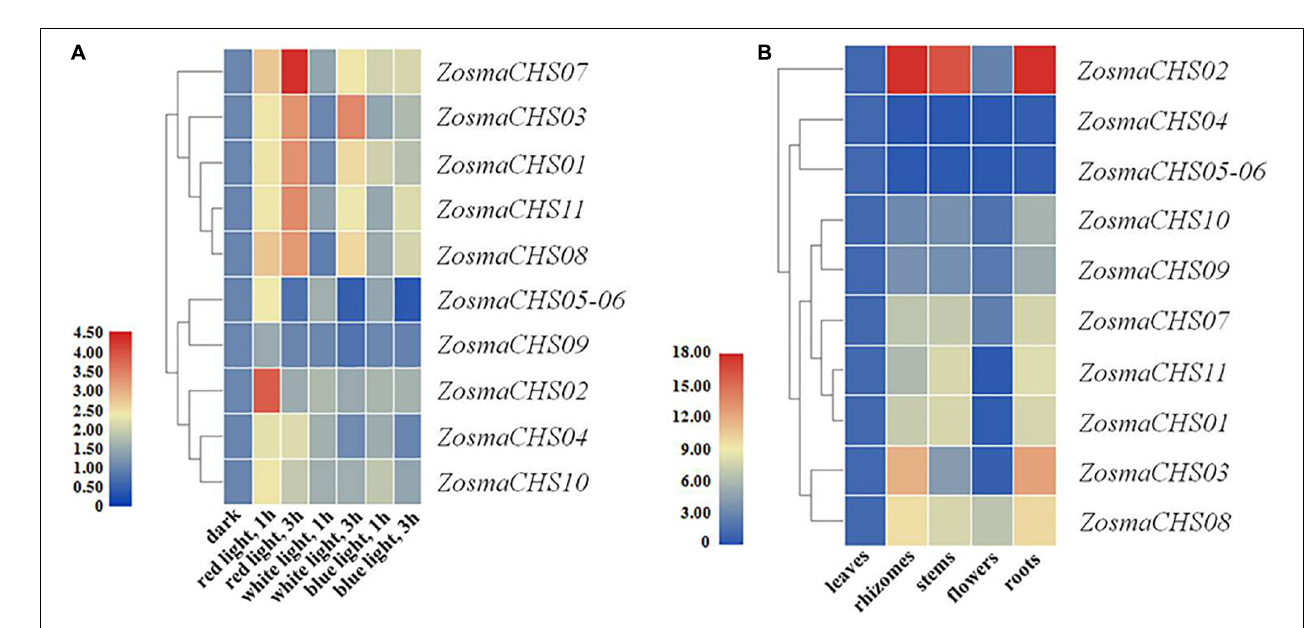
FIGURE 4 | Expression patterns of ZosmaCHS genes. To calculate the relative expression level, the expression of ZosmaCHS gene under dark condition was set as control. Gapdh was used as reference gene. Relative level of expression was transformed by log2 (2 − (cid:49)(cid:49) CT + 1). ZosmaCHS05 - 06 represented the sum of ZosmaCHS05 and ZosmaCHS06 expression level because of their high sequence similarity. (A) Expression patterns of ZosmaCHS genes in different light conditions by qRT-PCR. (B) Expression patterns of ZosmaCHS genes in five tissues by qRT-PCR.